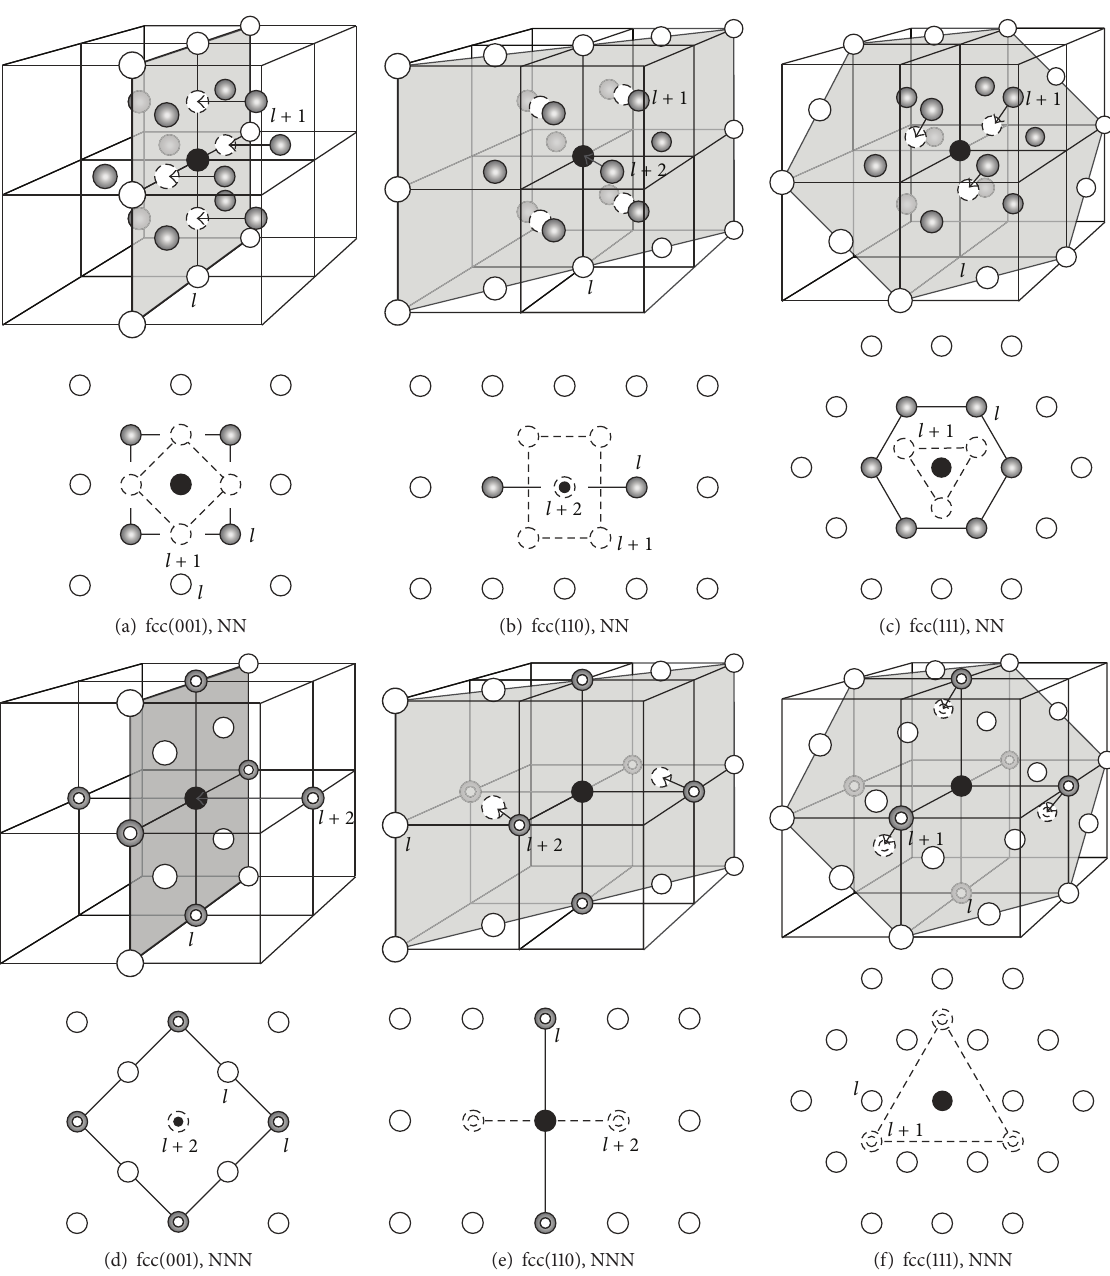
Figure 12: The same distribution and mapping of neighbors as in Figure 10 but for fcc thin films. Due to the large number of lattice sites in this case circles are shown only for spins from the plane 𝑙 and for respective